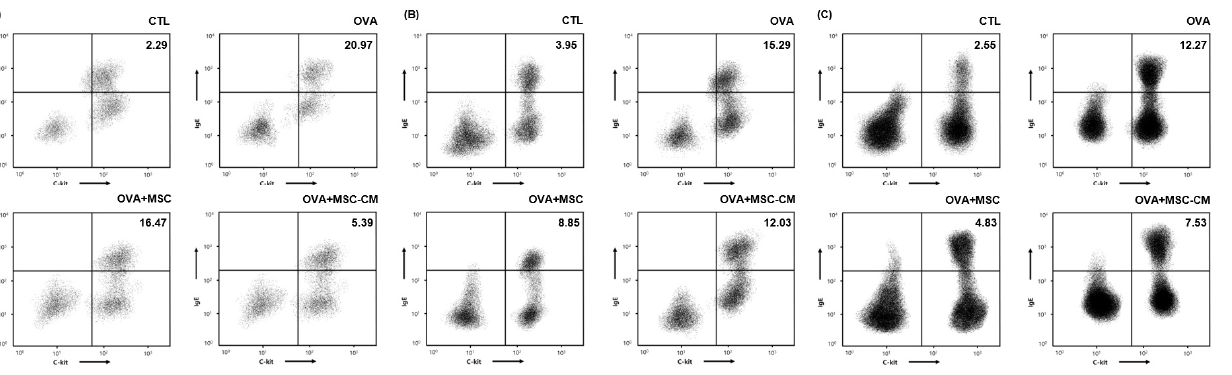
Figure 5. OVA challenge increased IgE+ c-kit+ mast cells and MSC or MSC CM reversed the change in the ear skin, mLN, and SI tissue. IgE+ c-kit+ mast cells in the ( A ) ear skin, ( B ) mLN, and ( C ) SI tissue measured by flow cytometry are shown. Mean percentage (mast cell counts/total cell counts) is shown in the right upper side. Ig, immunoglobulin; mLN, mesenteric lymph node; MSC, mesenchymal stem cell; MSC CM, mesenchymal stem cell culture medium; OVA, Ovalbumin; SI, small